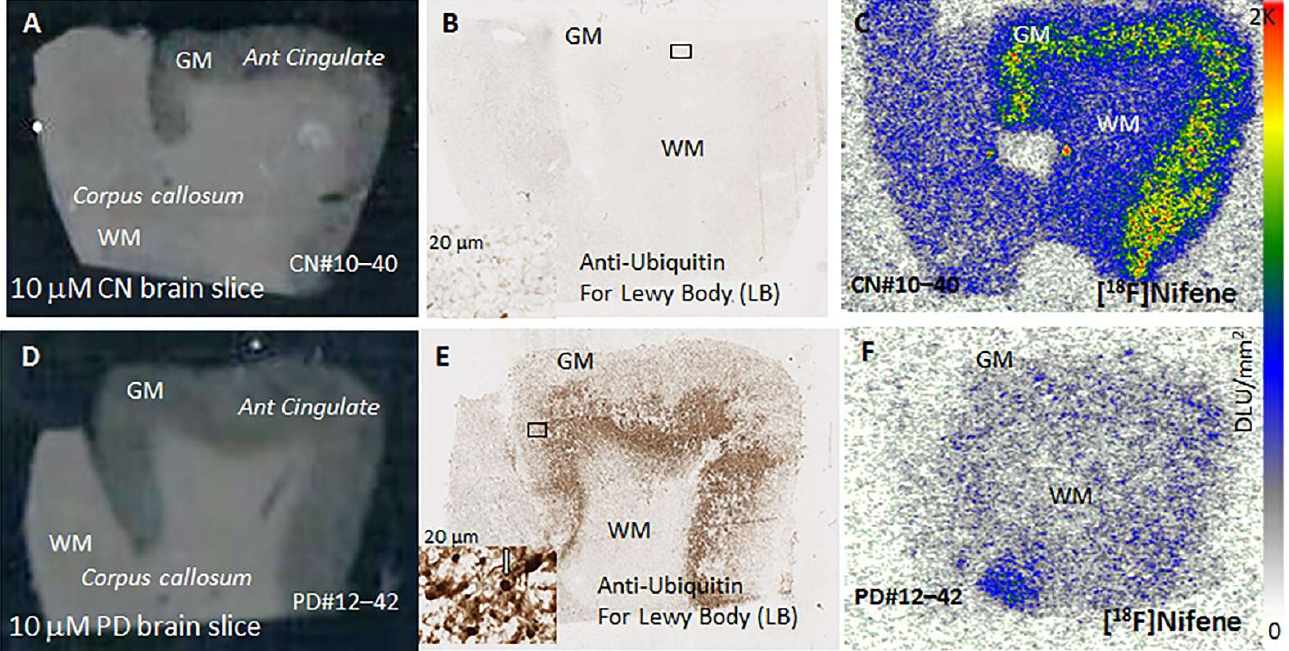
Figure 8. Comparison of [ 18 F]nifene in post-mortem human PD versus controls. ( A ) CN brain section, 10 micron thick consisting of grey matter (GM) anterior cingulate (AC) and white matter (WM) corpus callosum (CC); ( B ) ubiquitin IHC for LB; ( C ) [ 18 F]nifene binding in adjacent section; ( D ) PD brain section, 10 micron thick consisting of grey matter (GM) anterior cingulate (AC) and white matter (WM) corpus callosum (CC); ( E ) ubiquitin IHC for LB; inset at 20 mm shows LB and measured diameter of LB in inset was 6 to 9 microns; ( F ) [ 18 F]nifene binding in adjacent section showing reduced binding compared to CN brain.